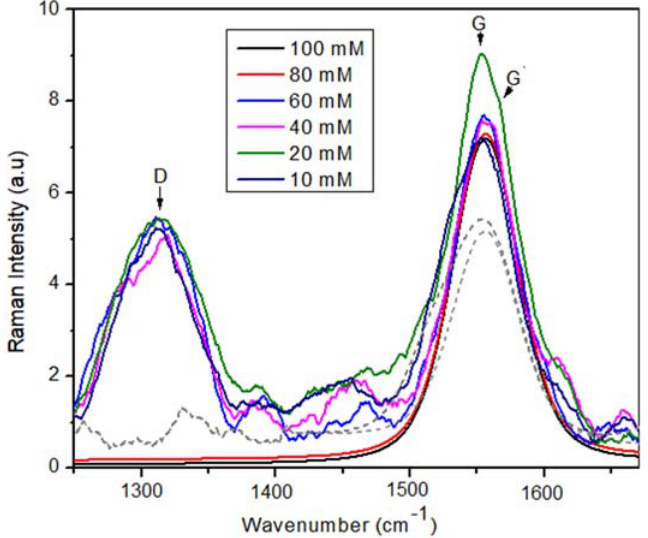
Figure 7. Raman spectra of MWCNT dispersions in water with different TX ‐ 100 molarities.